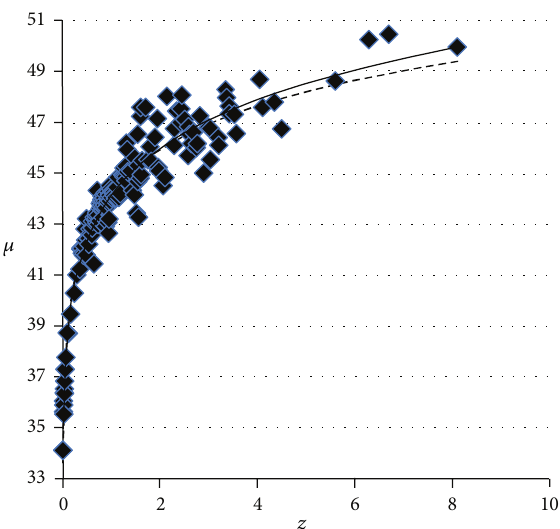
Figure 1: RS/ 𝜇 data, fitted with the logarithmic 𝜇 = 2.4761 × ln (𝑧)+ 44.198 (dashed line) and the potential function 𝜇 = 44, 102 × 𝑧 0.0593 (solid line).